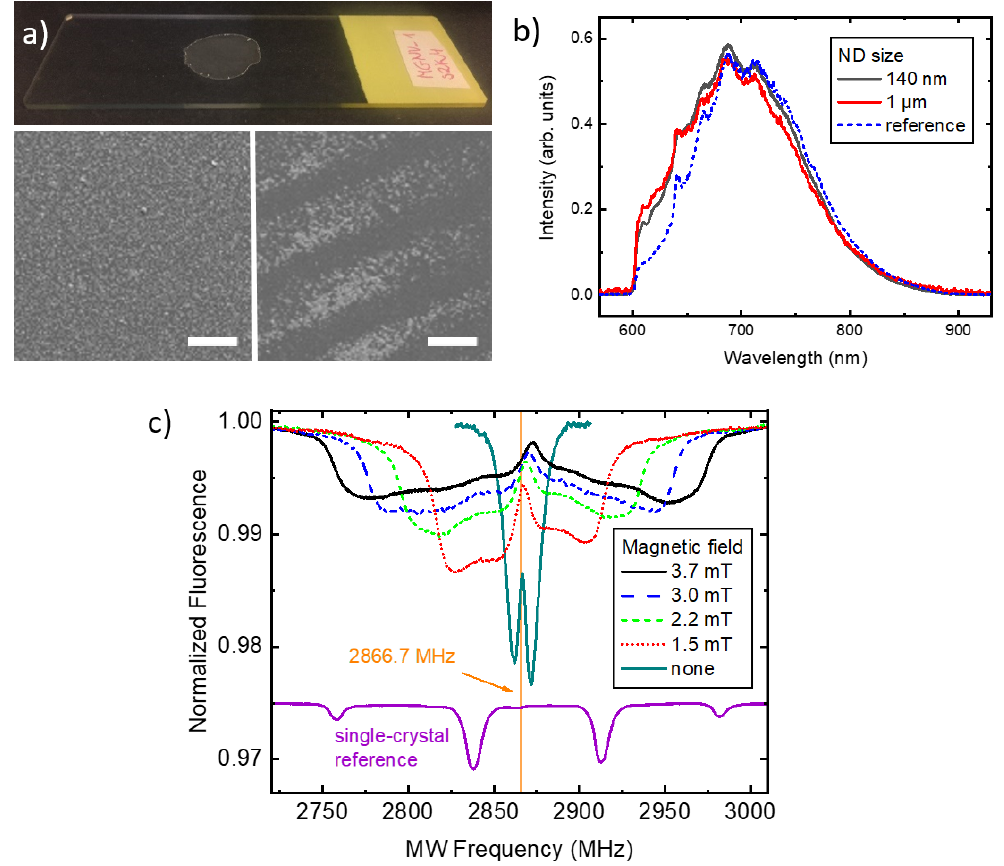
Figure 2. Signals observed with deposited ND ensembles. ( a ) 1- µ m-size NDs deposited on a microscope slide (top panel) and SEM images of uniform (left panel) and self-organized (right panel) areas. The scale bar size is 100 µ m; ( b ) Optical fluorescence spectra of 140-nm and 1000-nm-size NDs, and a reference bulk type Ib diamond; ( c ) ODMR recorded with a dried 140-nm ND solution as a function of the magnetic-field strength. Vertical line indicates the symmetry frequency for the zero field. The reference signal was recorded with a [111]-oriented single-crystal in a 4 mT field (scaled-down by a factor of 10 and vertically offset for